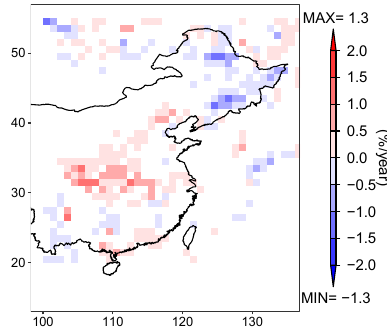
Figure A2. Temporal trend of forest fraction from 1982 to 2013 derived from our classified maps (color bar is the slope in percentage per year).